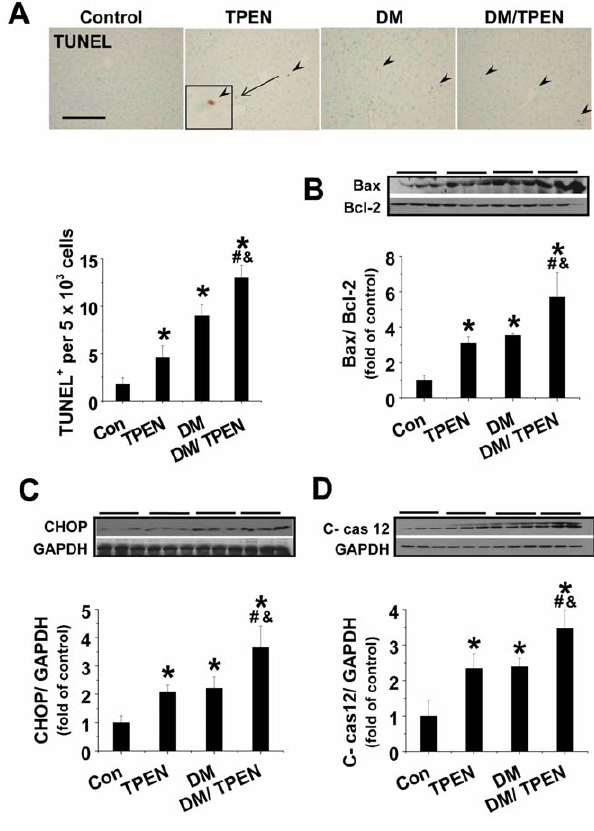
Figure 3. Diabetes and TPEN treatment induced hepatic apoptosis, which was related to hepatic ER stress. Apoptotic cell death was examined by TUNEL staining, followed by the quantitative analysis of the positive cells (A). The expression of Bax and Bcl-2 were detected by Western blotting assay and the ratio of Bax/ Bcl-2 was present (B). ER stress-associated cell death was examined by Western blotting for the expression of CHOP (C) and cleaved caspase 12 (D). Data are presented as mean 6 SD (n=6 at least in each group). DM: diabetes. * P , 0.05 vs. control group; # P , 0.05 vs. TPEN group; & P , 0.05 vs. DM